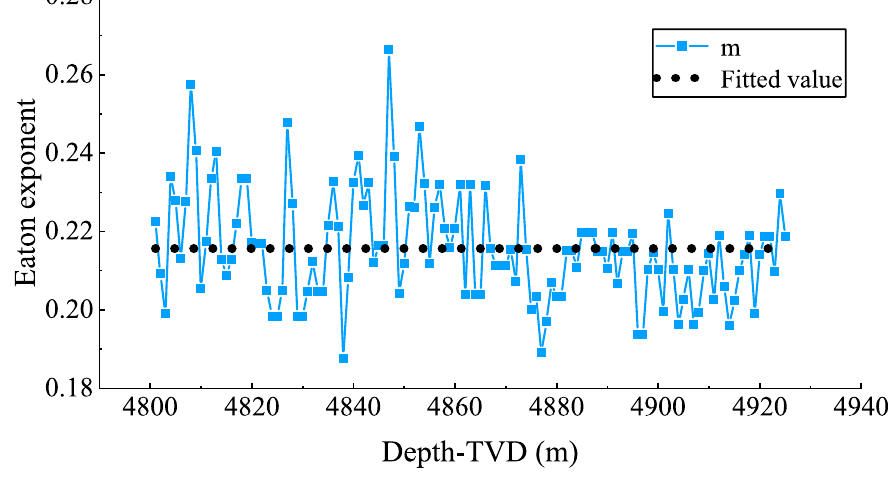
Figure 2. Estimation of the Eaton exponent from well L. The well M is a sidetracking well, 6510 m deep, and was sidetracked from 5195 m with a maximum inclination of 20.12 degrees. In this well, PDM was used extensively for compound drilling, so both the influence of wellbore friction and the contribution of PDM to the total MSE should be considered. The most realistic downhole parameters can be obtained using MWD tools, but they are costly. Here, the downhole torque was computed from surface measurements (hook load and wellhead torque), and the results are plotted in the Figure 3b. The overall compliant trend of downhole torque is lower than the wellhead torque due to the friction of the drill string with the wellbore wall. Moreover, as the depth increases, the friction gradually increases. In the absence of reliable torque measurements, some studies have estimated torque from WOB, bit coefficient of sliding friction and bit size. The same operation was made here. The sliding friction coefficient of the bit is related to the type of bit, lithology, rock strength, mud weight and bit wear. To minimize the error in calculating MSE, it is reasonable to take 0.25 for roller-cone bits and 0.5 for poly-crystalline-diamond-compact (PDC) bits [45].